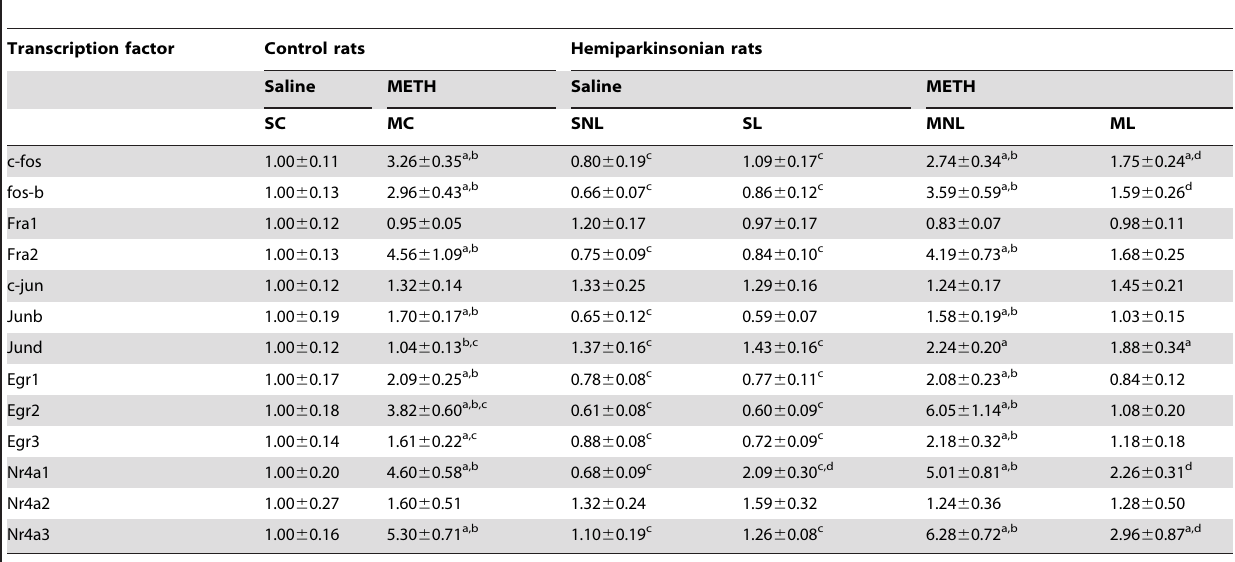
Table 6. Effects of METH on striatal expression of transcription factors in hemiparkinsonian rats.